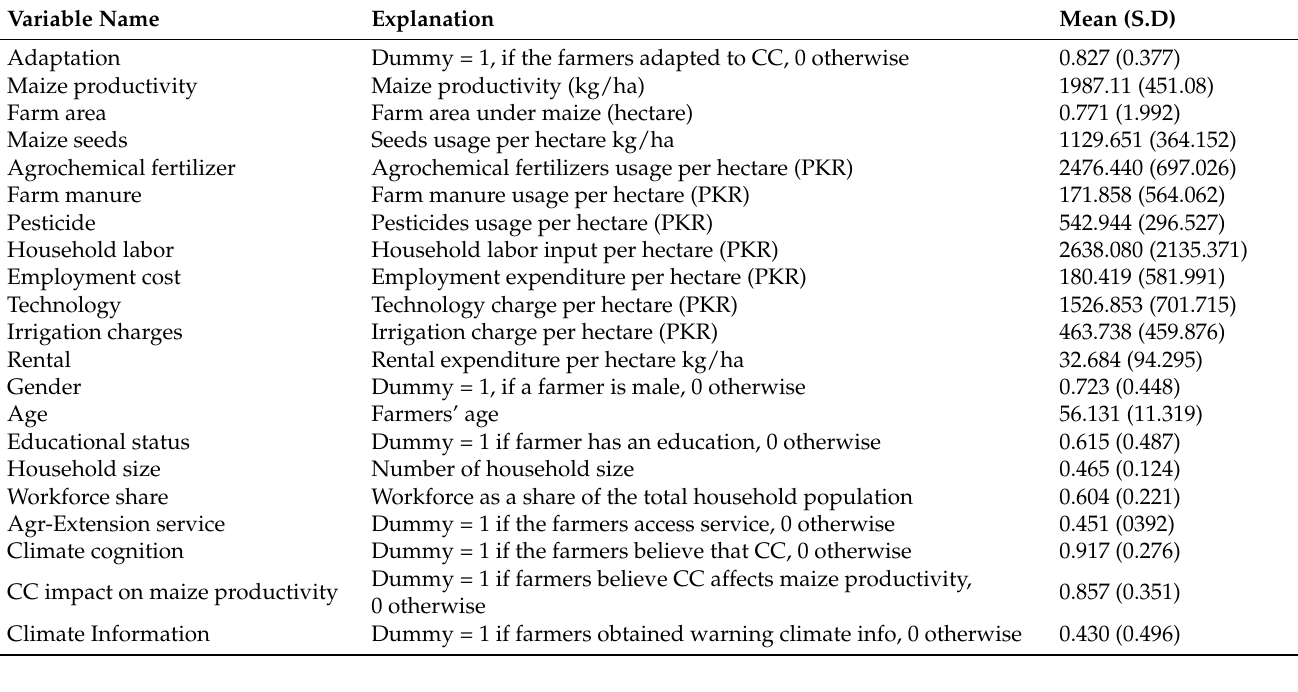
Table 1. Variable names, definitions, and descriptive statistics for the sample.